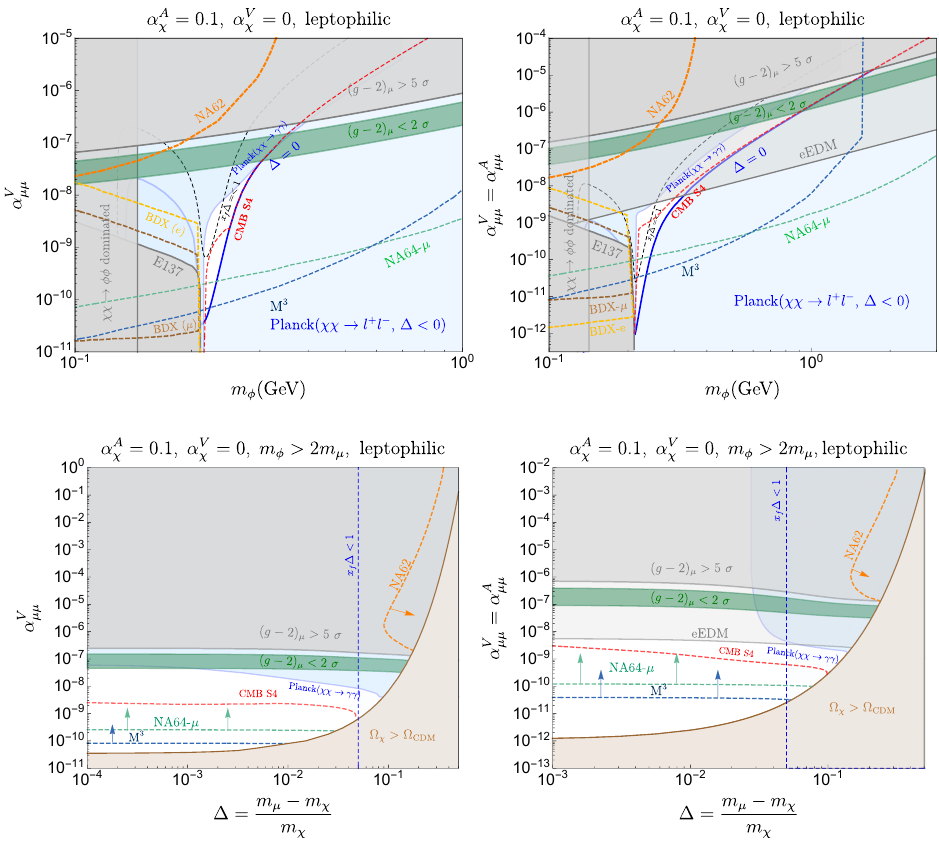
Figure 4 . Theoretical and experimental constraints on Forbidden DM annihilations through a leptophilic light Higgs. We show constraints from the E137 electron beam-dump experiment [70], measurements of the muon anomalous magnetic moment [39–41], the upper bound on the elec- tric dipole moment of the electron [92], and Planck constraints on DM annihilations [56]. We include projections from CMB-S4 [72] and the following future beam-dump experiments: BDX [73], LDMX [14, 67], M 3 [14, 67], NA62 [69, 74], NA64- µ [75–77], and M 3 [14, 67]. In the upper (lower) row, we choose ∆ ( m φ ) to match observed relic density in the white region. Ordinary annihilations into pairs of mediators set the relic density in the shaded gray region. In the brown area Forbidden DM has too large of an